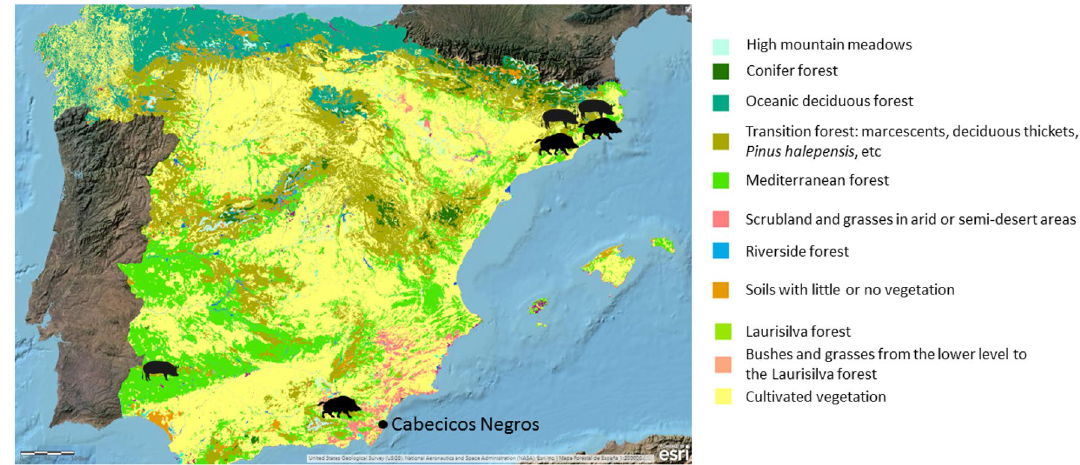
Figure 1. Vegetation map of the Iberian Peninsula with the location of the reference subspecies and the Cabecicos Negros site (https:// www. arcgis. com/ apps/ Viewer/ index. html? appid= c4c06 0eddf d447a f833c dbf43 90158 50#!).